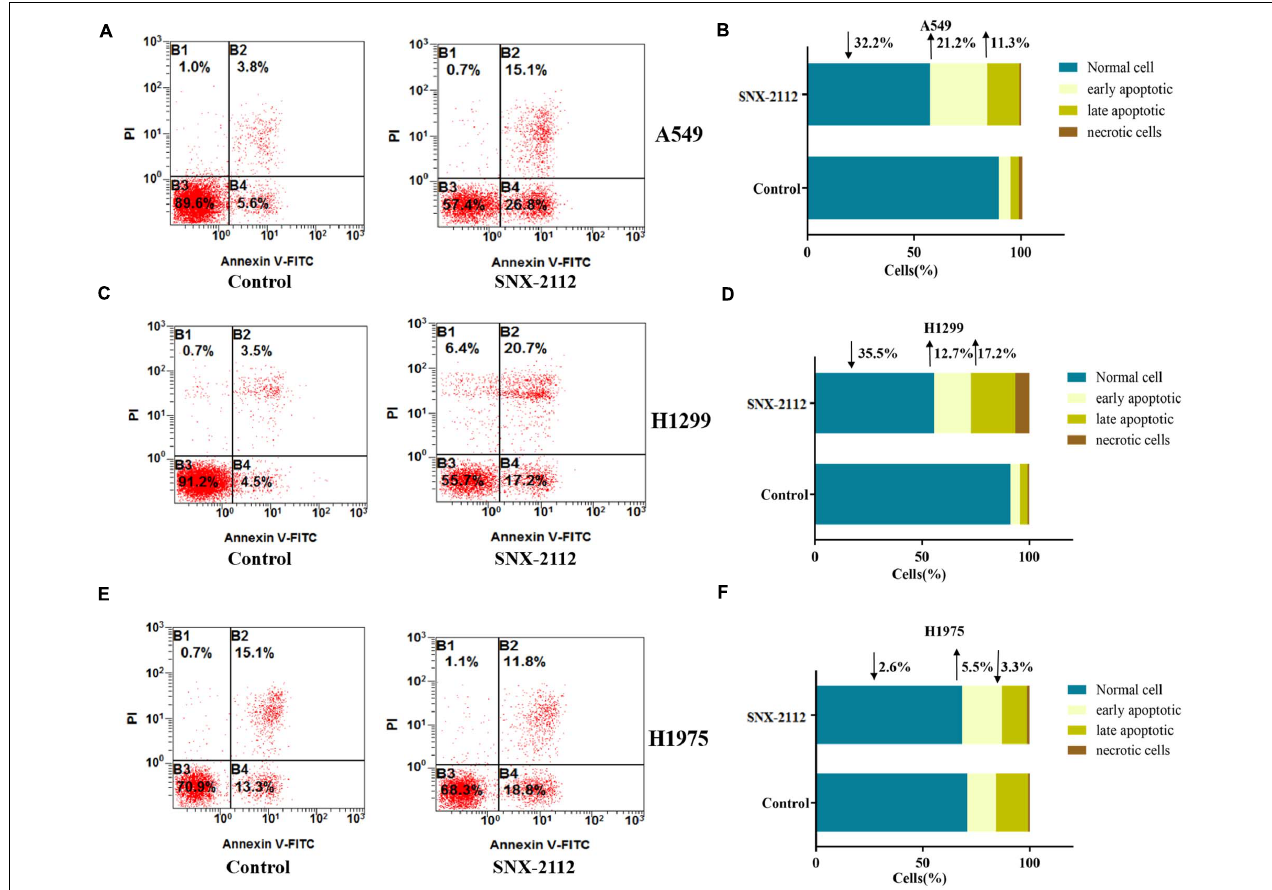
FIGURE 3 | SNX-2112 aggravated NSCLC cell apoptosis. SNX-2112 aggravated apoptosis of A549 cells (A) , H1299 cells (C) , and H1975 cells (E) . Apoptosis determined by flow cytometry method for cells treated with SNX-2112 or DMSO. Distribution difference of A549 cells (B) , H1299 cells (D) , and H1975 cells (F) in four quadrants. The four quadrants represent as B3, Normal cell; B4, early apoptosis; B2, late apoptosis; and B1, necrotic cells. It was revealed that SNX-2112 aggravated NSCLC cell apoptosis. Annotations: Control, treated with DMSO for 72 h; SNX-2112, treated with SNX-2112 for 72